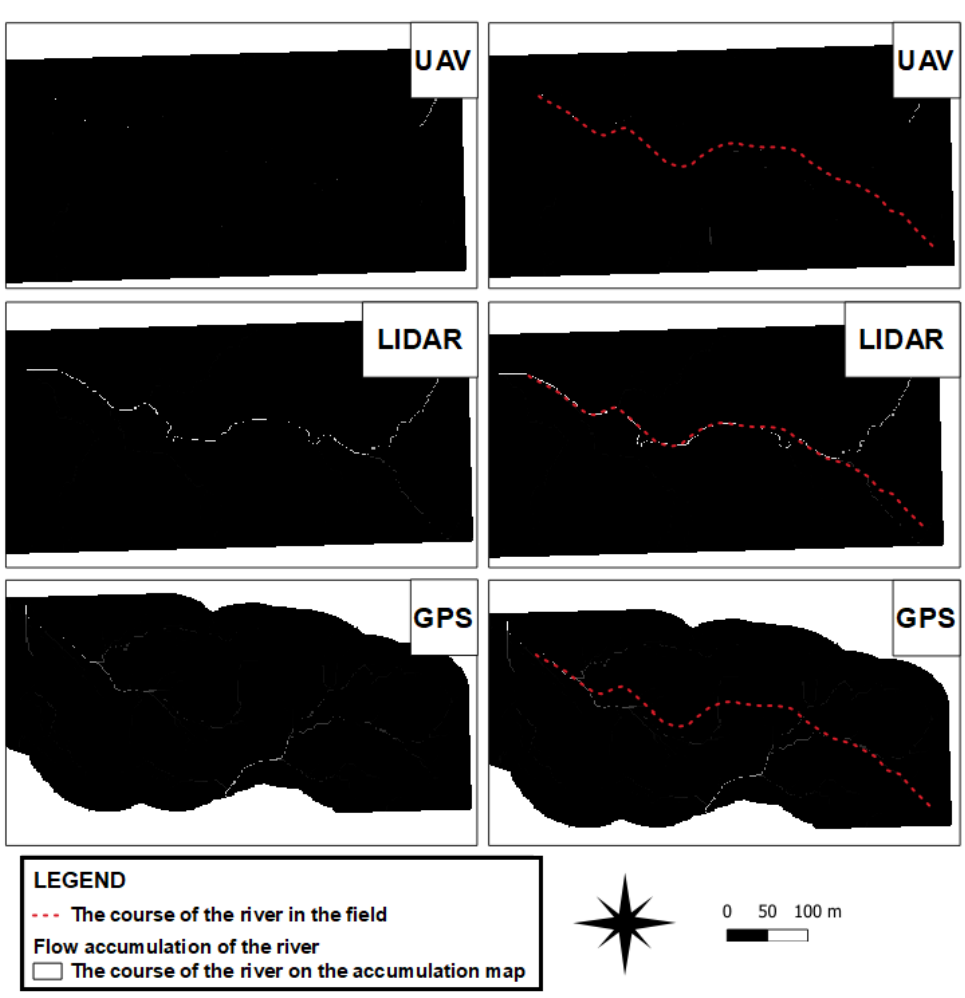
Figure 9. Flow map generated from the DEM created based on surveying data by photogrammetric methods using UAV, LIDAR and GNSS/RTN; source: own elaboration.